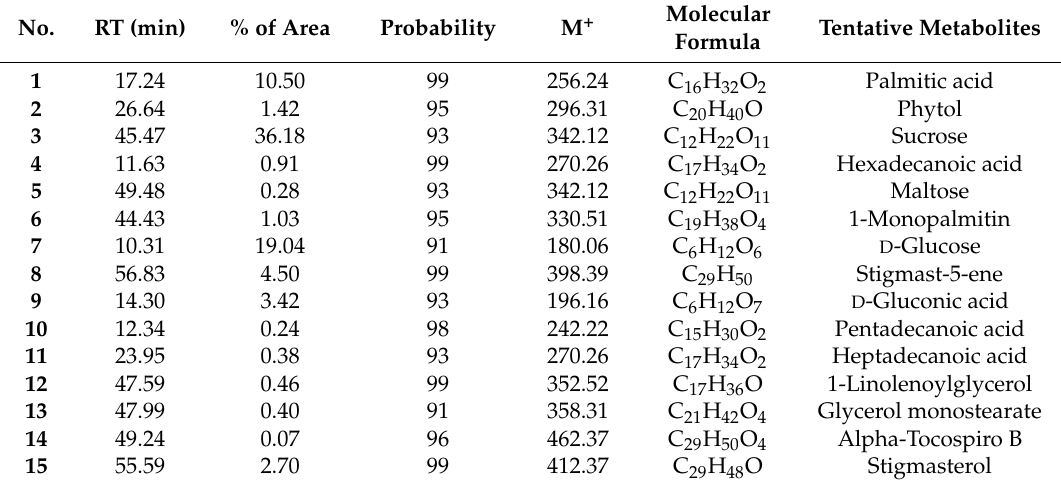
Table 2. Compounds identified in the C. nutans leaves extracts through GC-MS analysis.